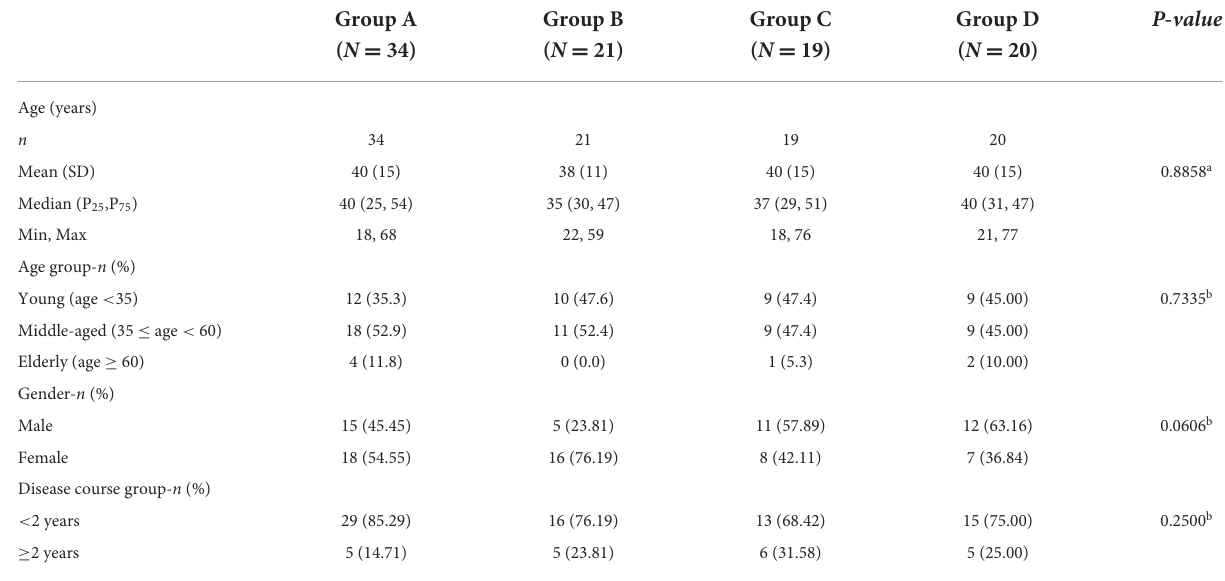
TABLE 1 General characteristics of patients.